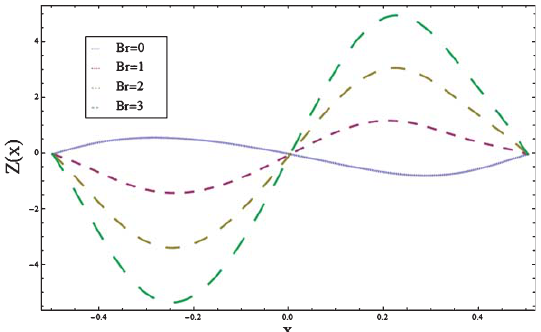
Fig. 11. Plot showing Z ( x ) versus x . Here a = 0 . 3, b = 0 . 5, d = 1, φ = π/ 4, (cid:14) = 1 . 5, Bi